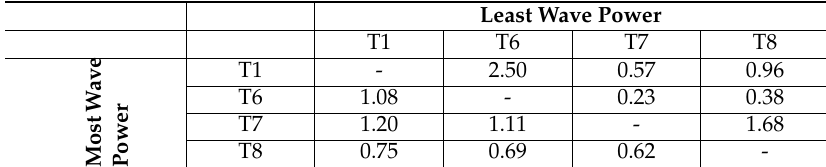
Table 6. Ratios for M factor1 (see Equation (3)) with oblique wave angles.